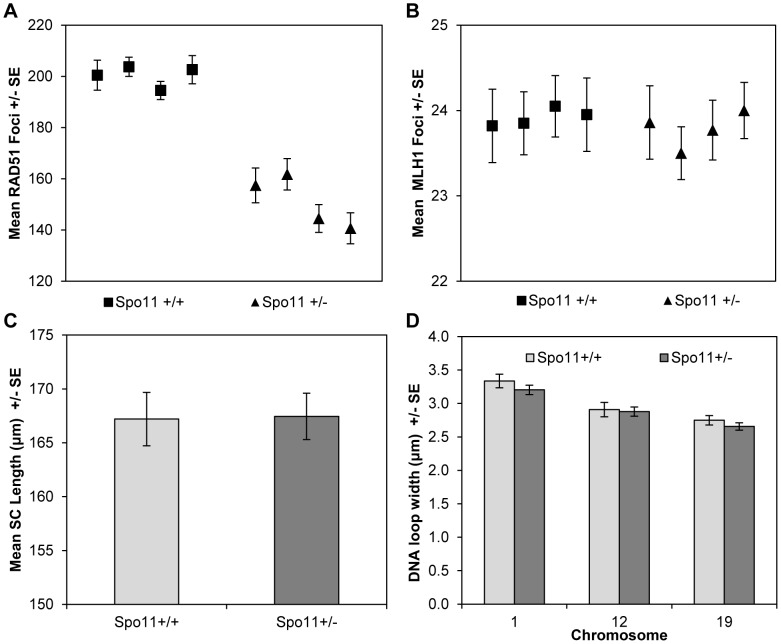

Spo11+/+ and Spo11+/− animals.(A) Mice heterozygous for a null allele of Spo11 exhibited a significant decrease in RAD51 foci (a marker of DSBs) by comparison to wildtype littermates. However, (B) the mean number of MLH1 foci (a marker of COs), (C) mean SC lengths and (D) mean DNA loop sizes were not different between the two genotypes.